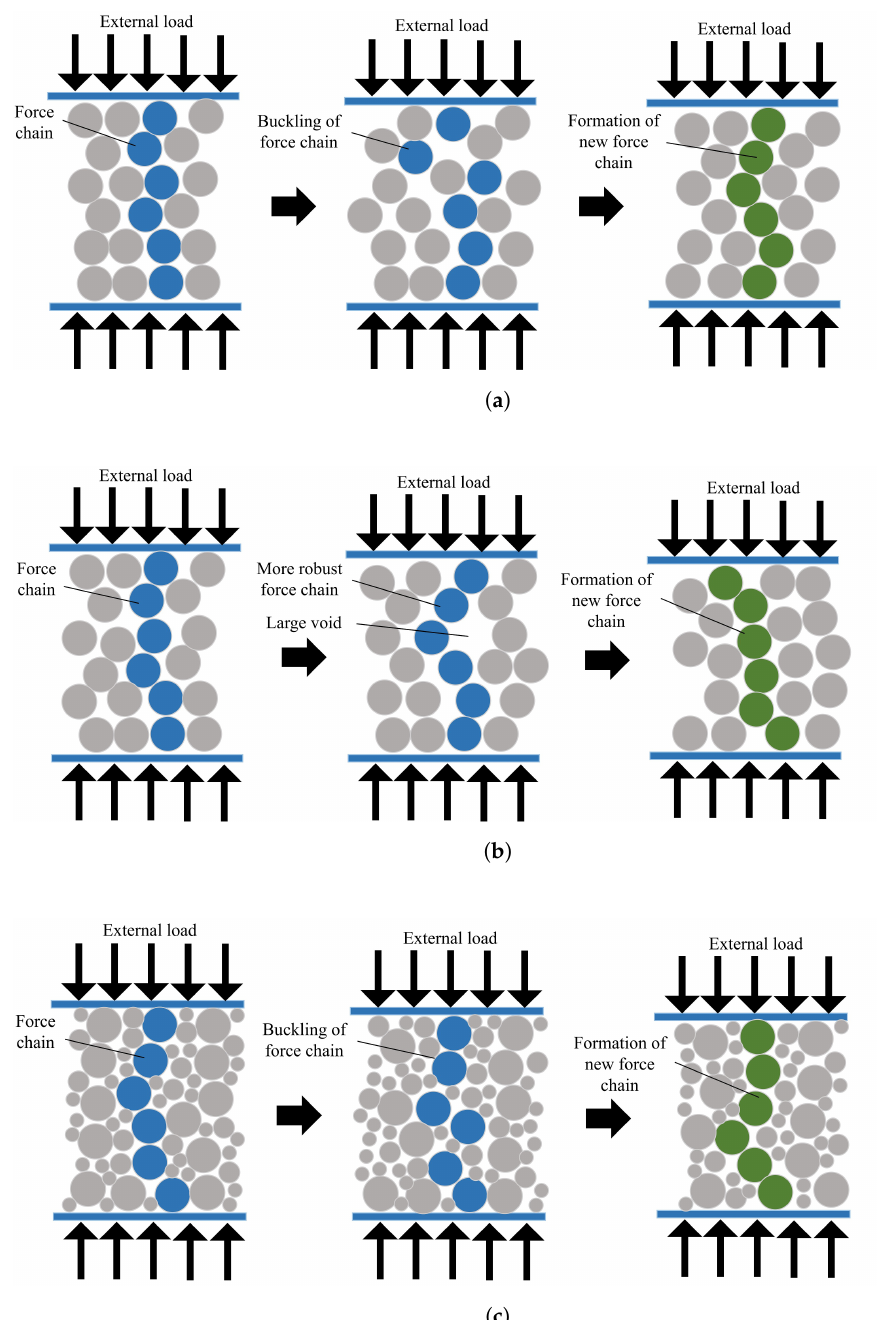
Figure 18. Deformation mechanism of a granular material ( a ) without rolling resistance and small particles, ( b ) with rolling resistance, and ( c ) with small